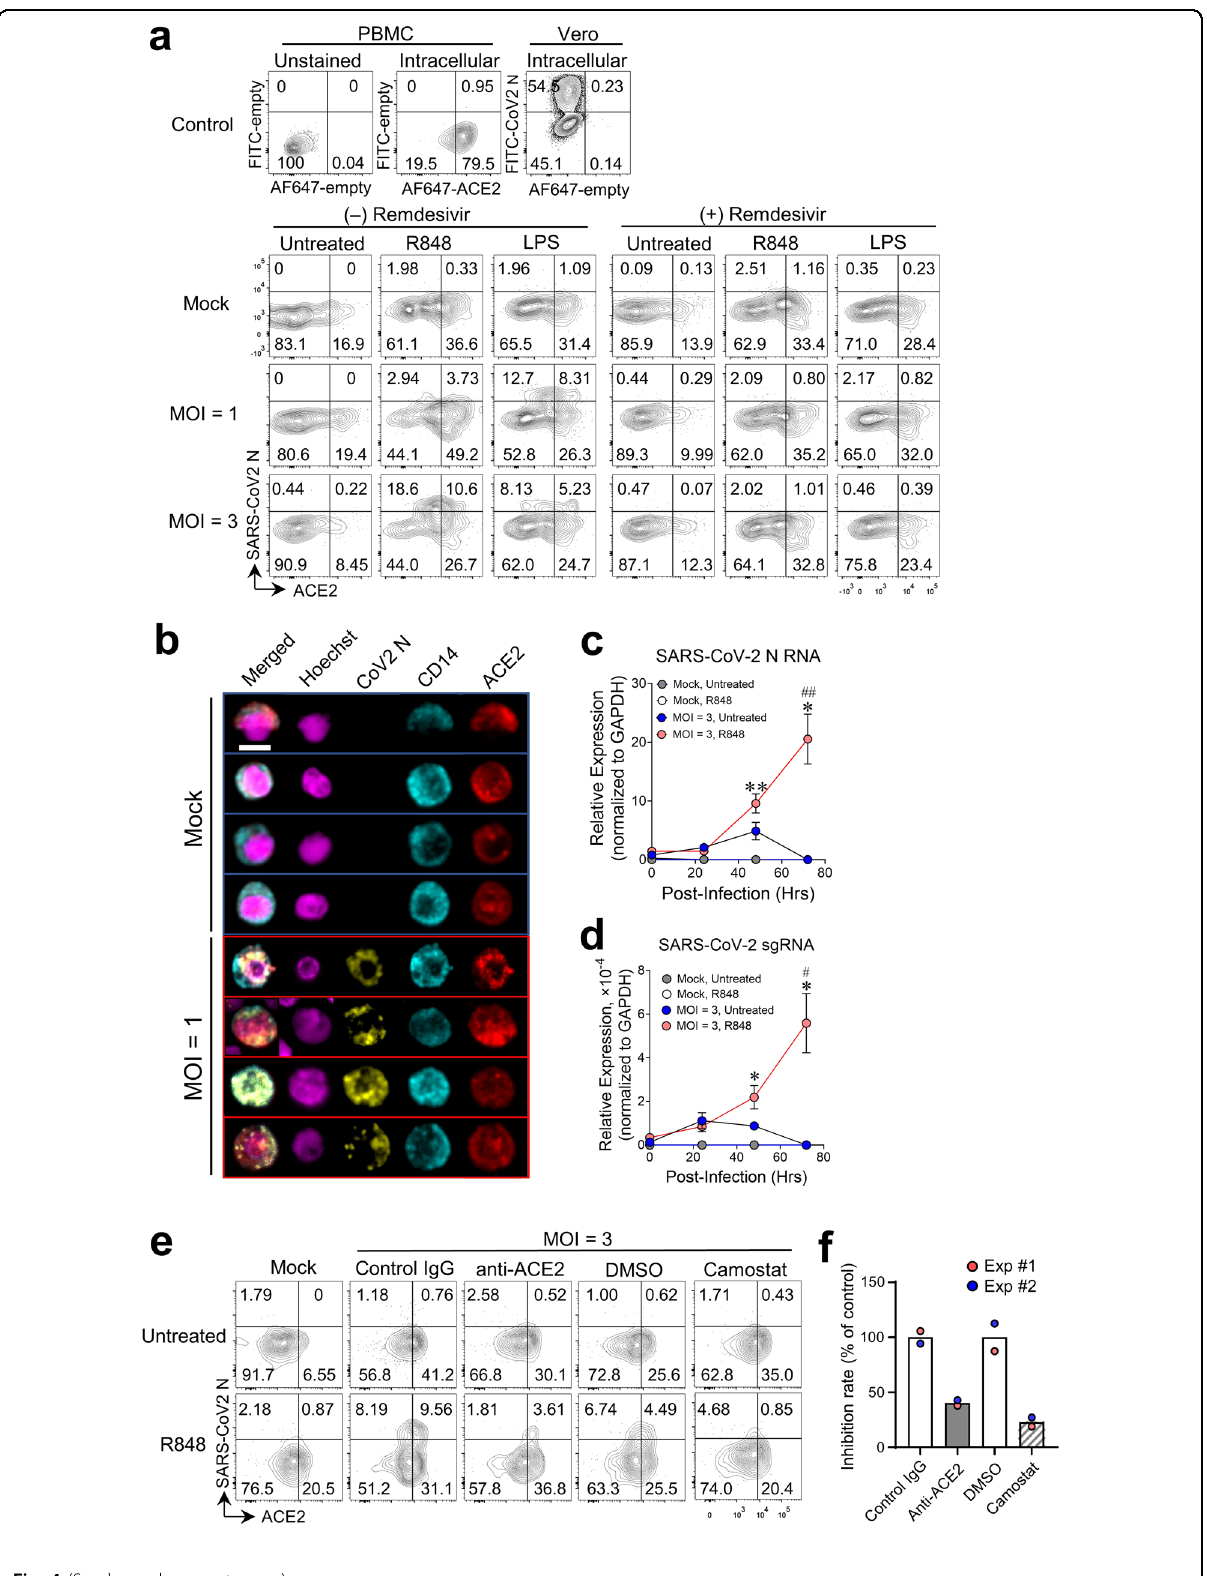
Fig. 4 (See legend on next